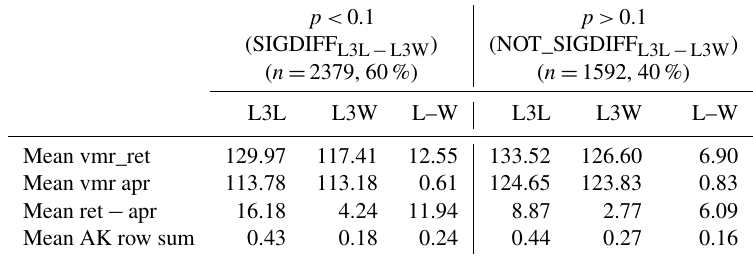
Table 2. Mean values for selected variables from L3L and L3W for coastal L3 grid boxes, matched retrievals only. Matched means that only days when both L3L and L3W are present and the L3O surface index is mixed are used to create the mean values analysed. Mean values are calculated and presented separately according to the results of a two-tailed Student’s t test (unequal variance) performed on mean retrieved VMR values in L3L and L3W ( n = 3971). Mean L3L − L3W differences are also shown for each subset (L–W). p <